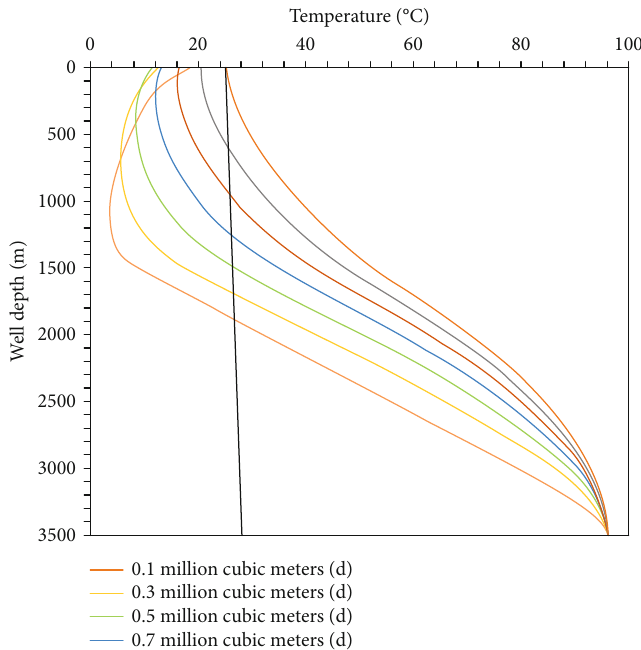
Figure 7: Hydrate formation region prediction with di ff erent test rates.